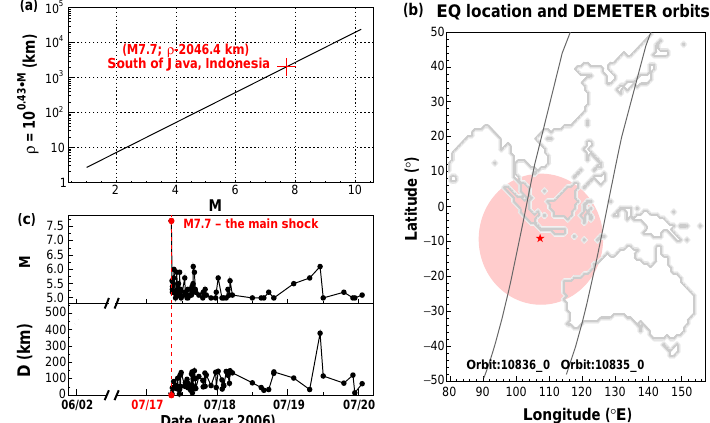
Figure 1. The information of the main shock ( M 7.7, 17 July 2006, south of Java). (a) The radius ( ρ = 10 0 . 43 · M ) of earthquake preparation zone. (b) The location of the main shock (the red star) and its preparation zone (the light-red circle). The two black curves show two downward half-orbits (10835_0 and 10836_0) of DEMETER satellite in the daytime on day 2 before the main shock (15 July 2006). (c) The M ≥ 5.0 earthquakes occurred around the main shock from 2 June to 20 July 2006: (top) the magnitudes and (bottom) the distances from the main shock, where the two red dots represent the main